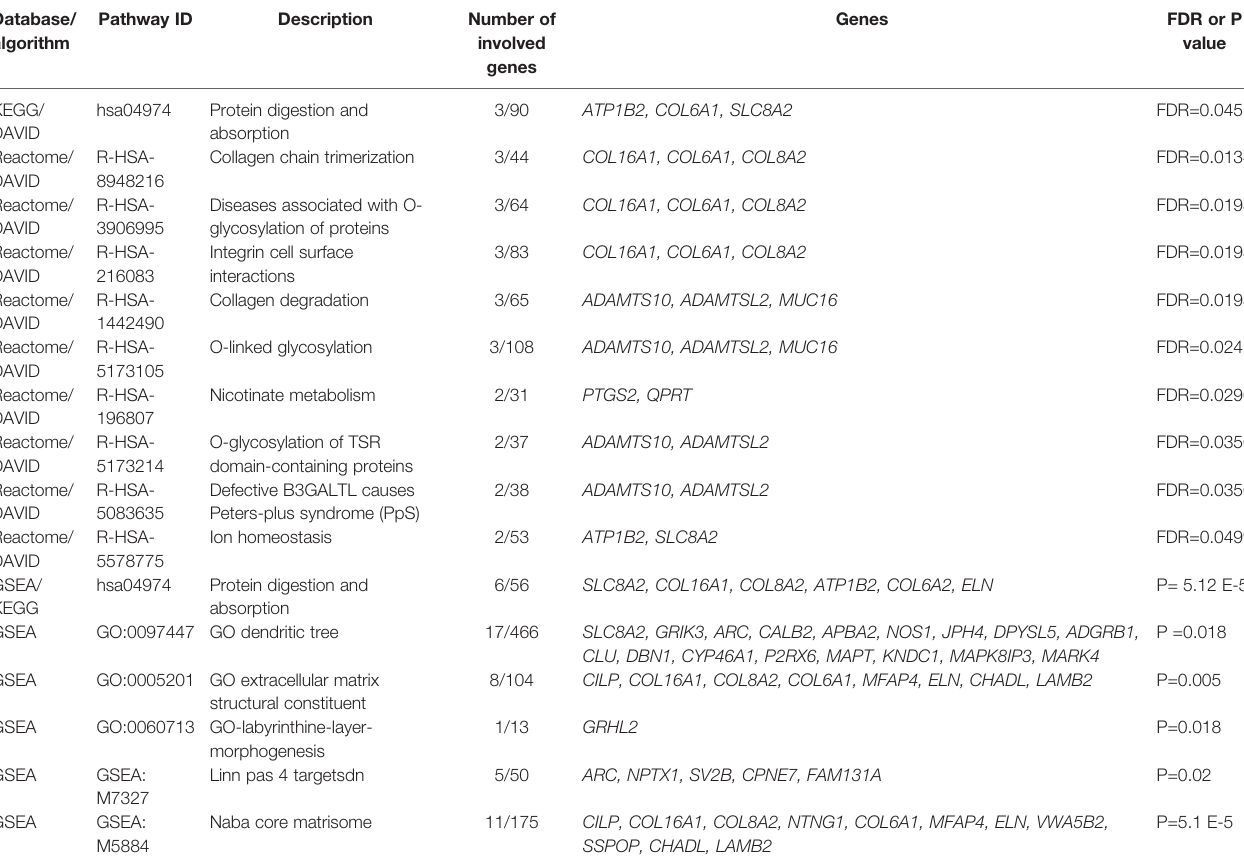
TABLE 4 | Pathway enrichment analysis results (FDR <